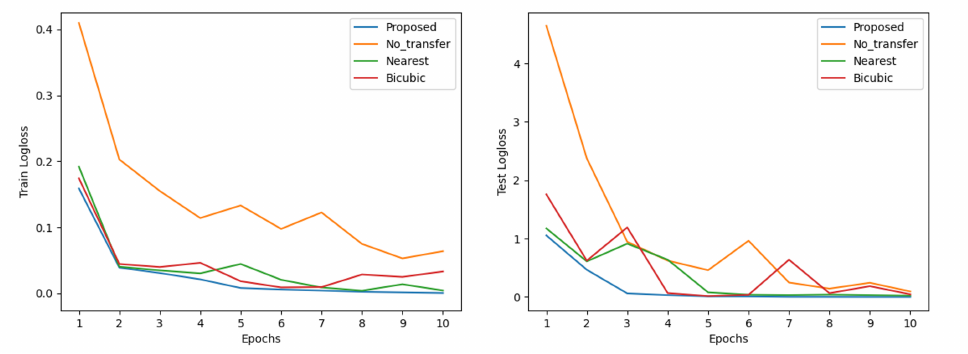
Figure 7. The changing trend of loss value with training